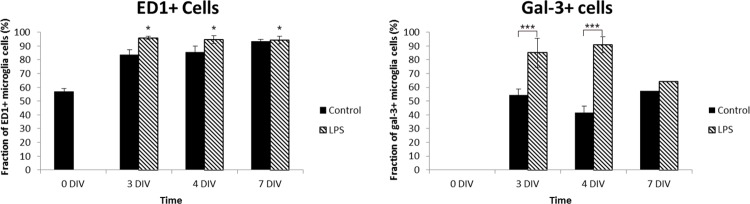
Quantification of ED1 and Gal-3-positive microglial cells.Quantification of fractions of cells expressing ED1 and Gal-3, respectively, of the total number of Iba1-stained cells. ANOVA analysis was performed for comparison between the LPS-treated group and the control groups. Data are expressed as mean±StDev (n = 3/group) *p<0.05, ***p<0.001.